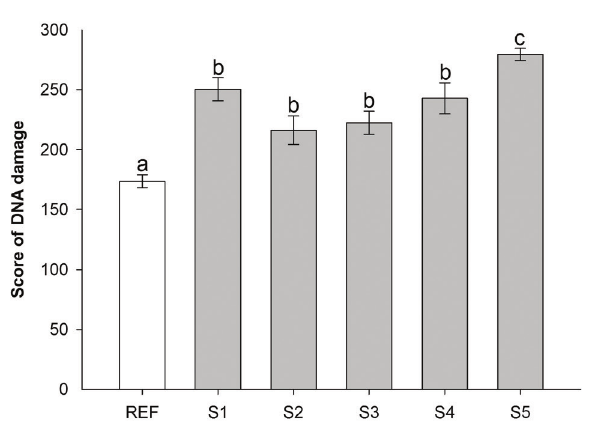
Fig. 6. DNA damage scores (mean ± SEM, n = 8) in erythrocytes of A. altiparanae exposed in situ for seven days in five sites along Água das Araras stream (S1, S2, S3, S4, and S5) and in a reference site (Ref). Different letters indicate significant differences between sites (P < 0.05).